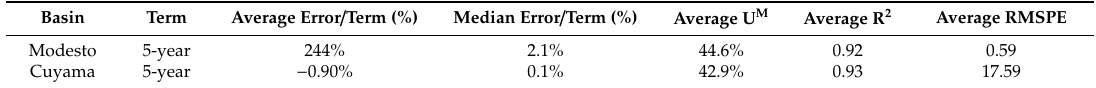
Table 7. Results of the 5-year simulations.